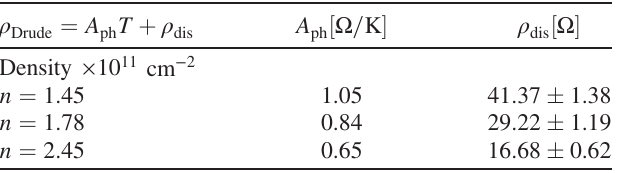
TABLE II. The linear function for the Drude resistivity ex- tracted from the straight geometry. We allow for variation of disorder distribution to explain the small difference between segments with two widths and use these low and high estimates to analyze the Ohmic resistance in the crenellated